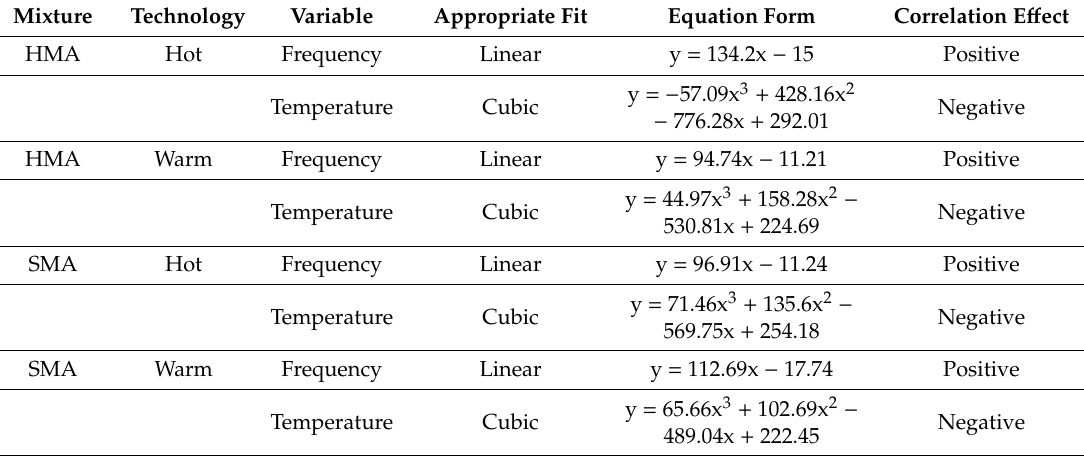
Table 7. Summary of the sensitivity analysis using the ANN-TLBO algorithm.